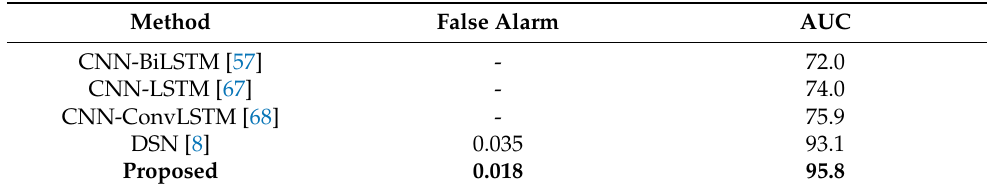
Table 3. Performance comparison of the proposed model with other SOTA over surveillance fight